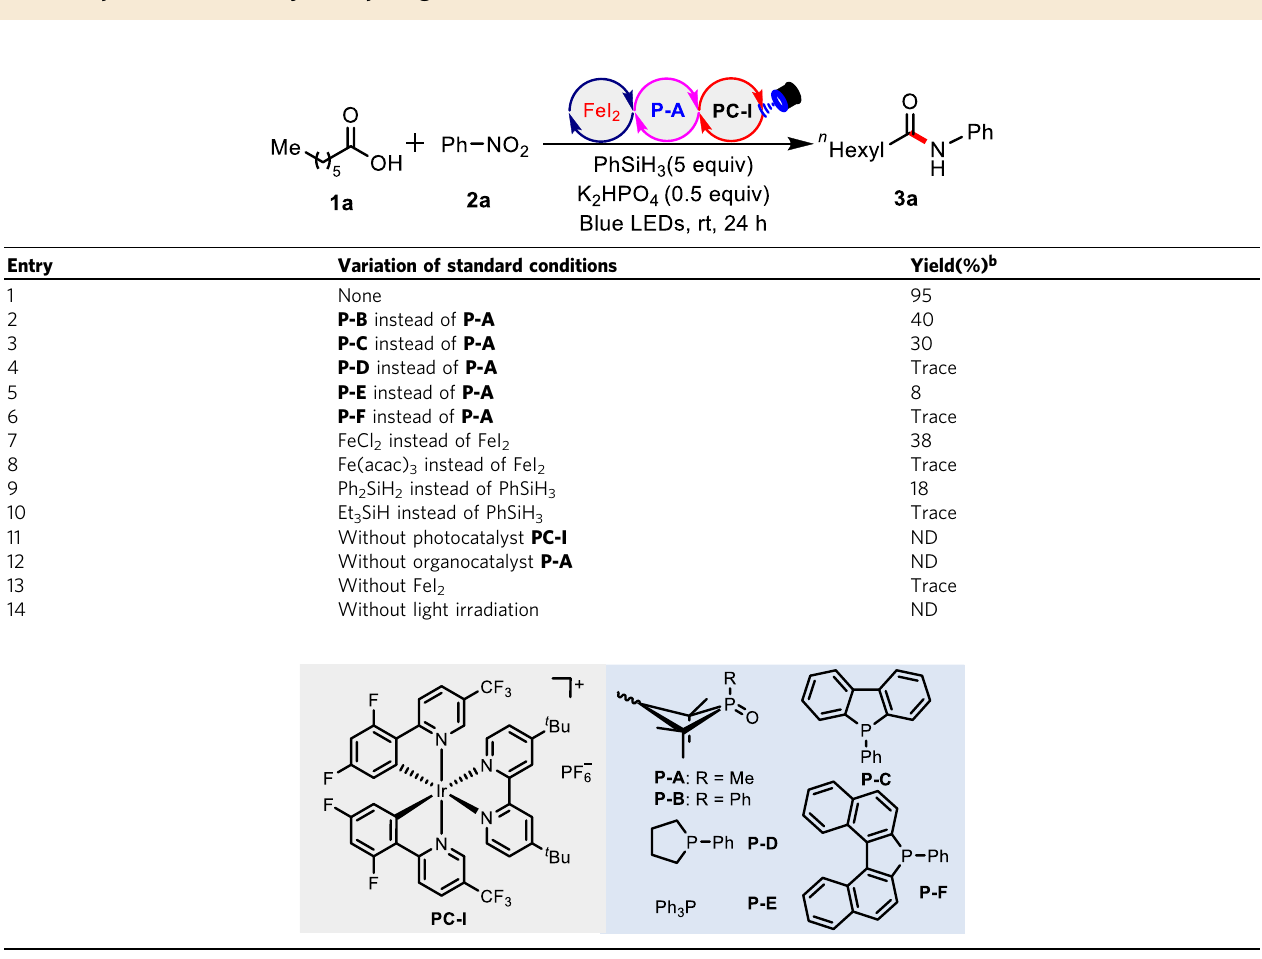
Table 1, the standard conditions include synergistic catalysis by